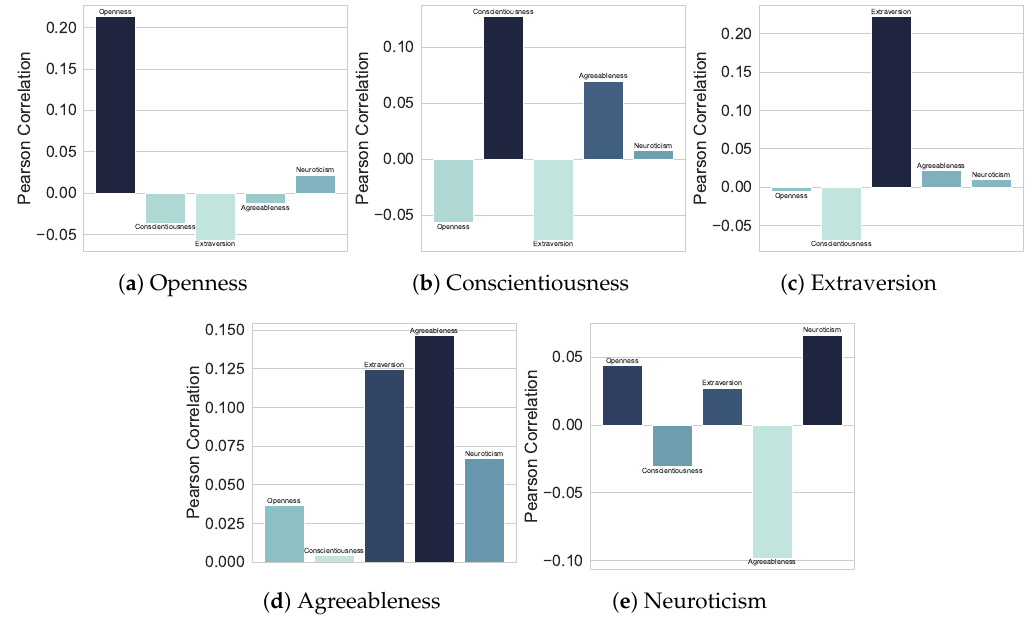
Figure 5. Pearson correlation coefficient between user questionnaire results (subfigures) and our model predictions on the user-chosen images (columns). Images predicted to be associated with certain personality trait are the most highly correlated with the corresponding questionnaire results.